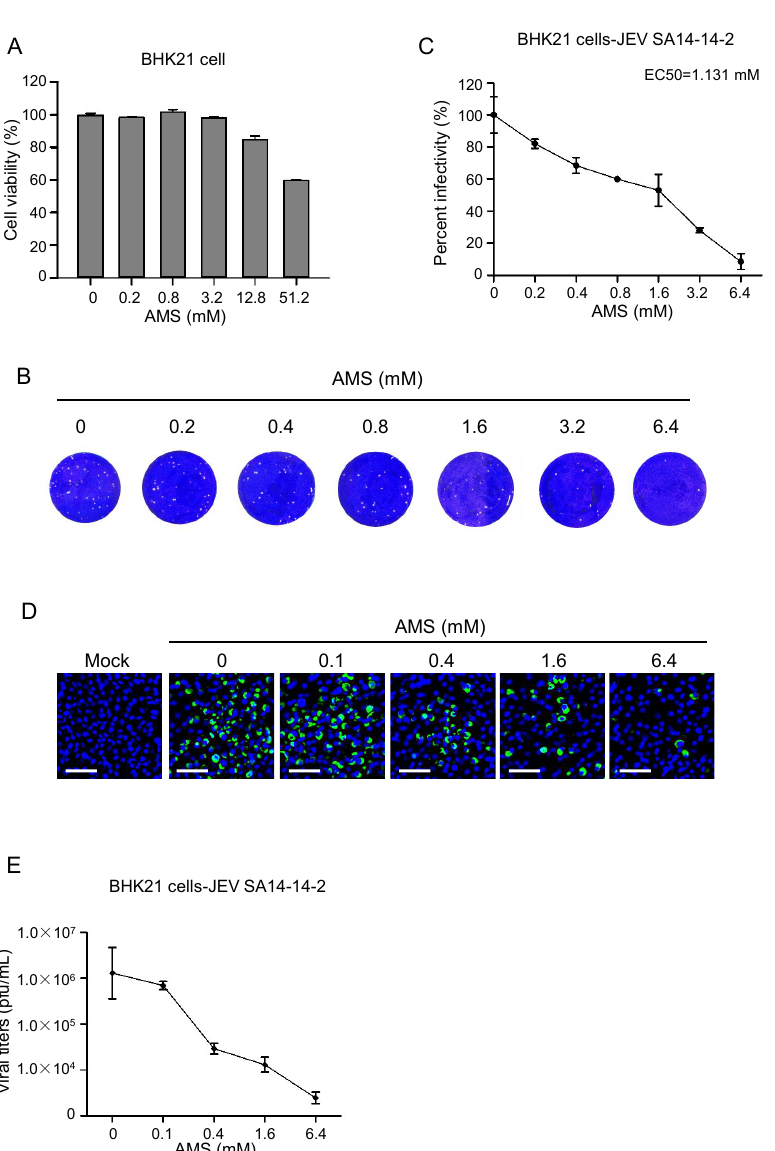
Figure 8. AMS inhibited JEV infection in BHK21 cells. ( A ) AMS cytotoxicity was assessed by the viability of BHK21 cells treated with AMS. Pre-seeded BHK21 cells were treated with increasing concentrations of AMS for 24 h, and then subjected to cell viability analysis using CCK-8. ( B , C ) Plaque reduction assay to determine the effect of AMS on JEV infection in BHK21 cells. BHK21 cells were treated with indicated concentrations of AMS during the addition of JEV strain SA-14-14-2 (100 pfu) and the inhibition efficiency was measured with plaque assay ( B ). Plaques were counted and percentage of plaque reduction was calculated ( C ). ( D , E ) AMS affected JEV strain SA-14-14-2 replication in BHK21 cells in a dose-dependent manner. JEV strain SA-14-14-2 was incubated with indicated concentrations of AMS and infected BHK21 cells at an MOI of 0.1. At 48 h p.i., the intracellular level of JEV E protein (green) in BHK21 cells was detected with immunofluorescence analysis ( D ). The titer of JEV in the supernatant was quantified by plaque assay ( E ). Bars, 50 µ m. Data are means ± SD of triplicate